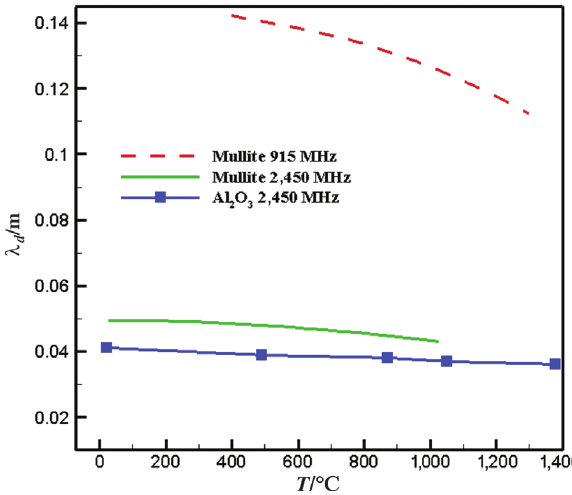
Figure 3: Temperature dependence of the microwave wavelength in mullite and Al 2 O 3 ceramics.